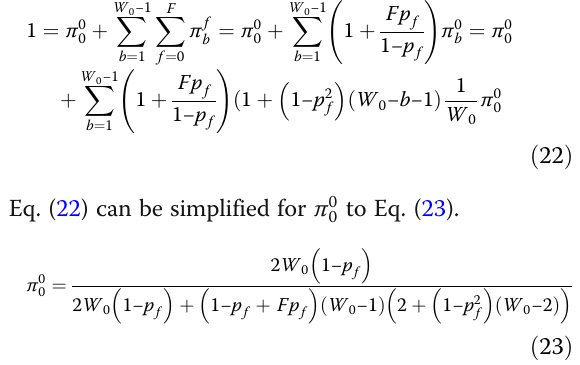
Eqs. (19) and (21) illustrate the values of the stationary f probabilities π b of Markov states in terms of freezing probability p f . By using the Markov chain normalization condition, we determine π 0